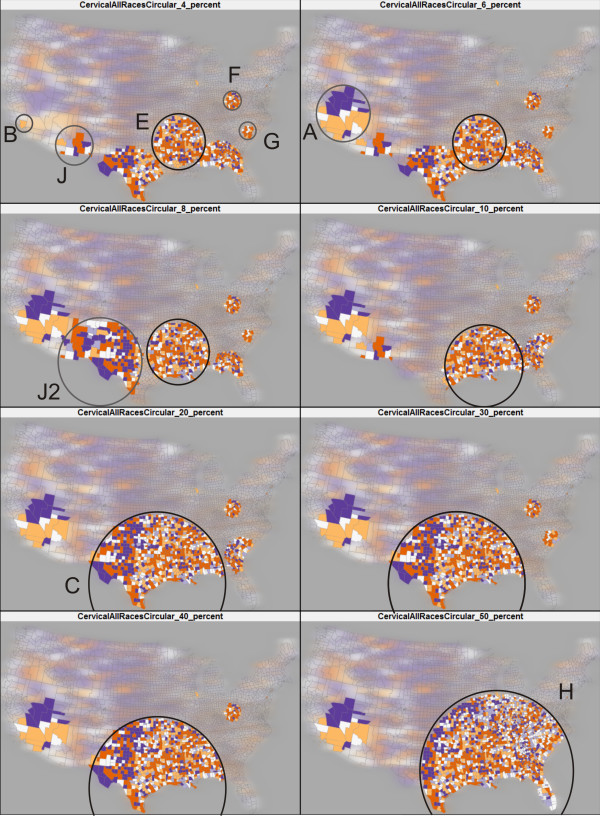
A map matrix displaying eight SaTScan runs for cervical cancer. The eight runs increase the maximum-size parameter systematically (4%, 6%, 8%, 10%, 20%, 30%, 40%, and 50%). As the maximum-size parameter is increased, the clusters reported by SaTScan vary in both location and size (as illustrated by the growing black circles and gray circles). For illustration purposes, we carefully draw circles around the boundary of the clusters. For each result, the primary cluster is in a black circle; and some secondary clusters are in gray circles.